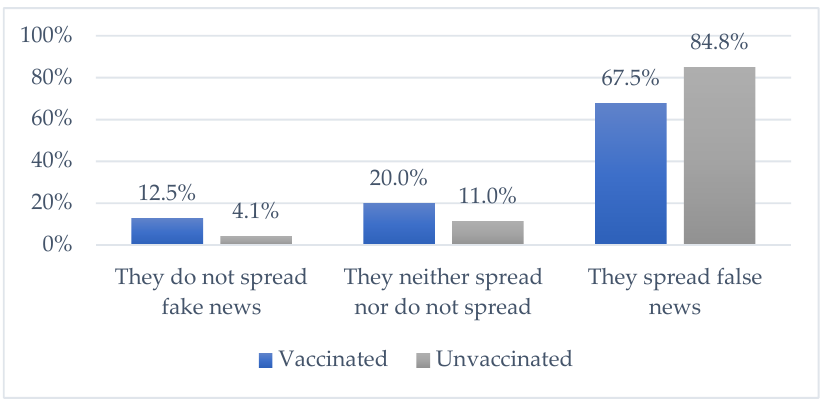
Figure 3. Is the media spreading false news regarding the vaccination against the COVID-19 virus? Next, students were asked through which media channels was the most misinforma- tion spread, and television channels with a national frequency were mentioned in first place with 34.5% (in Serbia there are five television channels with national frequency, one public media service and four commercial channels). In addition, they also highlighted social networking sites (16.3%), daily newspapers (14.3%), domestic internet portals (13.6%) and, in a slightly smaller percentage, radio stations with a national frequency (3.9%), local radio stations (3%), foreign internet portals (1.8%), foreign television channels (1.8%) and weekly newspapers (1%).